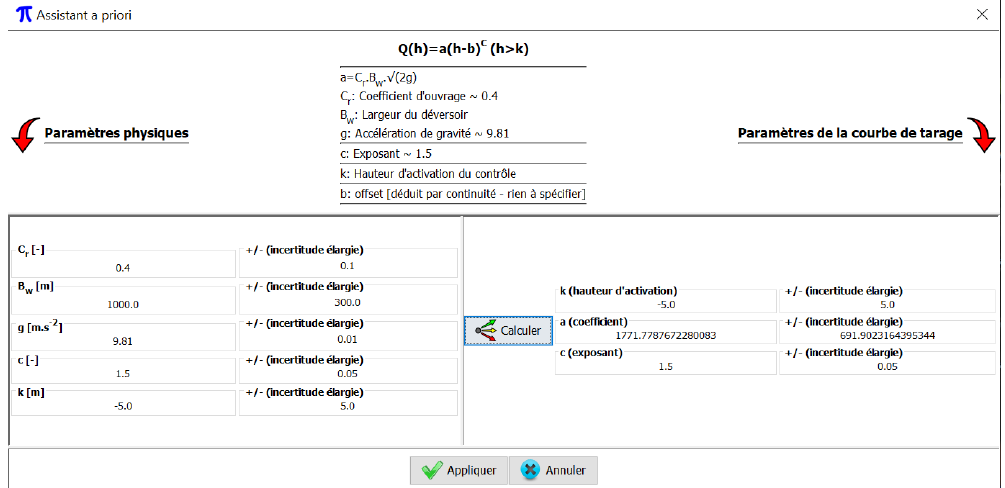
Figure 2. Définition a priori des paramètres du contrôle (déversoir rectangulaire) de la station du fleuve Congo à Brazzaville, via l’interface graphique du logiciel